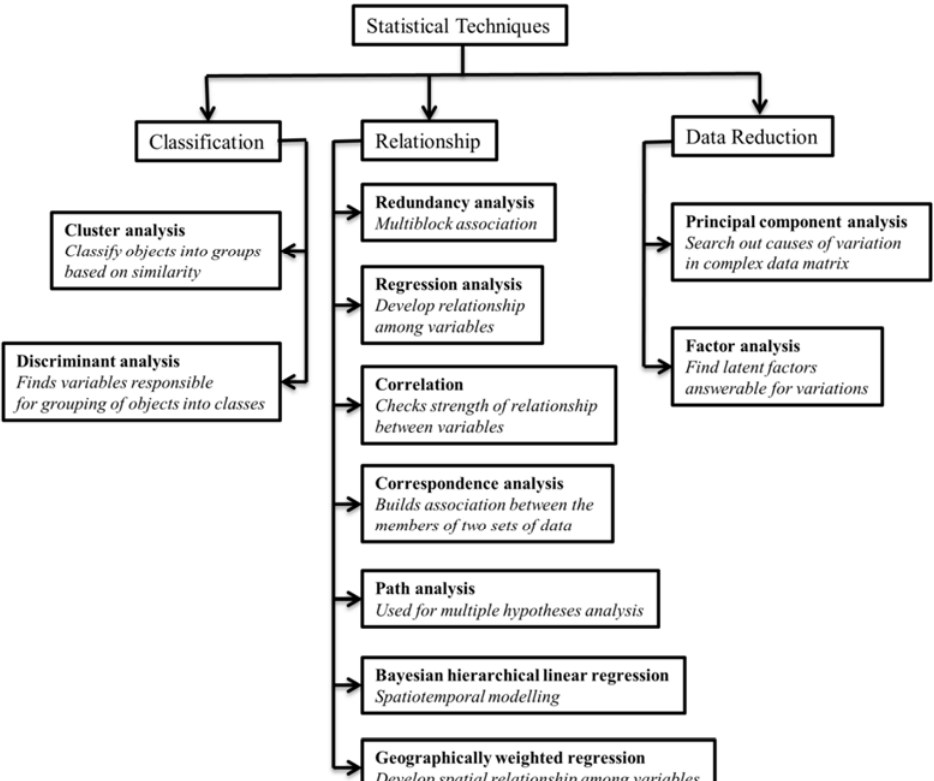
Fig. 3: Summary of different statistical techniques along with their purposes and applications